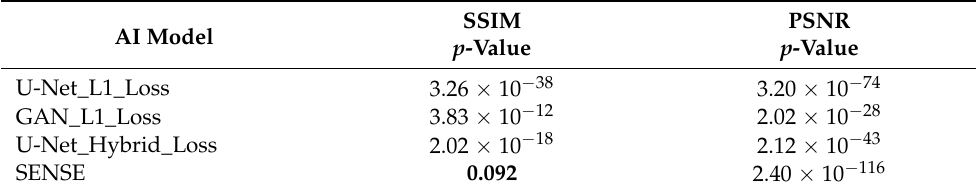
Figure 7. Graphical evaluation of SSIM and PSNR for studied models. Table 4. The results of Mann–Whitney U test for SSIM and PSNR of the studied AI models against the model with the highest SSIM and PSNR